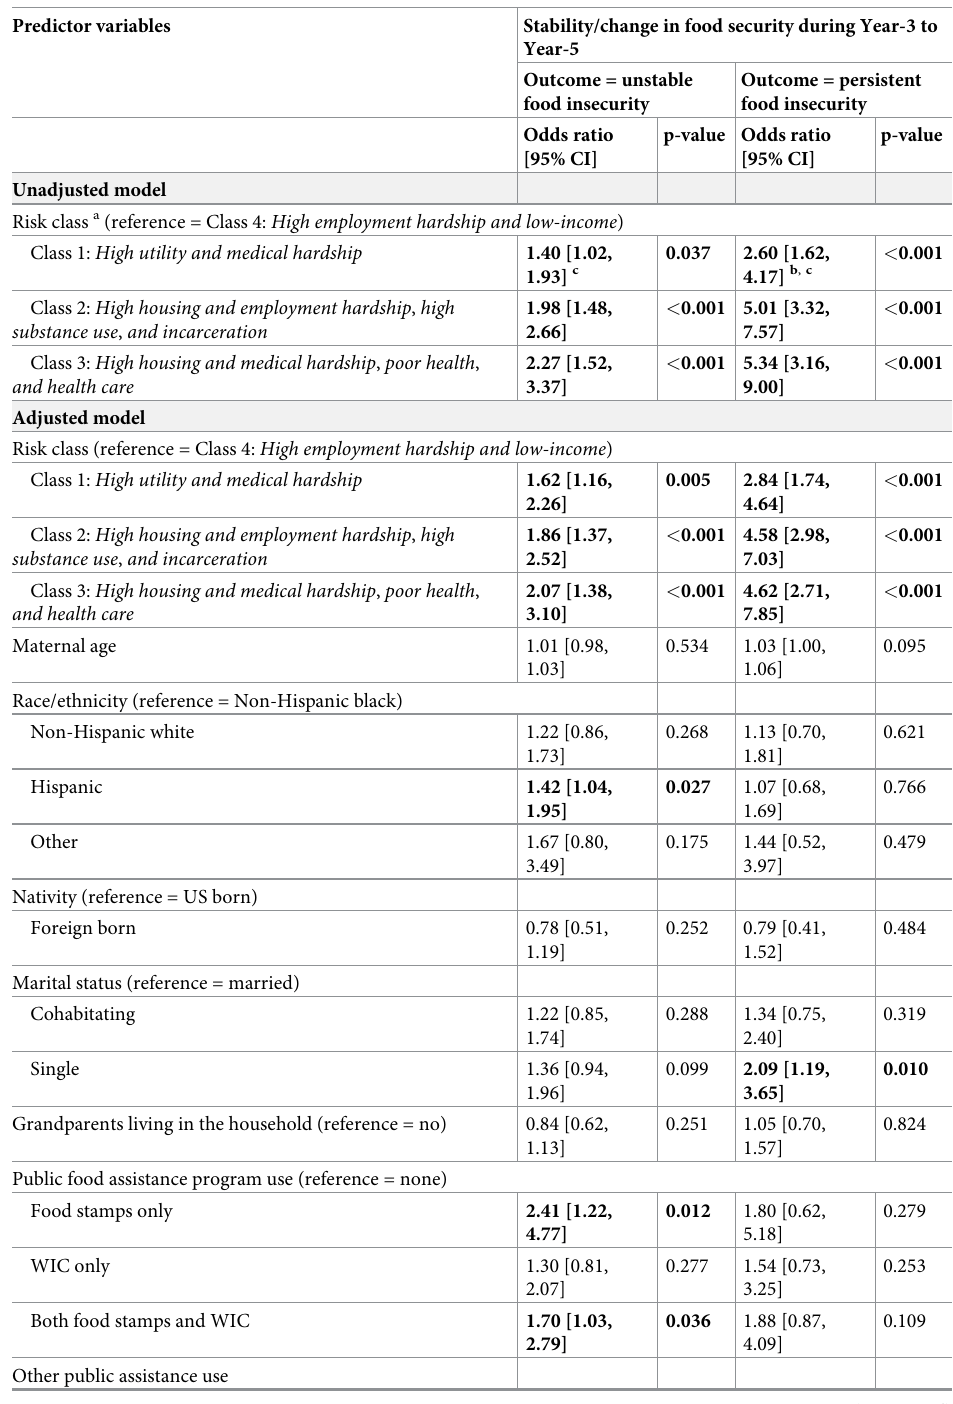
Table 6. Multinomial logistic regression analysis for latent risk classes predicting stability/change in food insecu- rity during Year-3 and Year-5 (n =